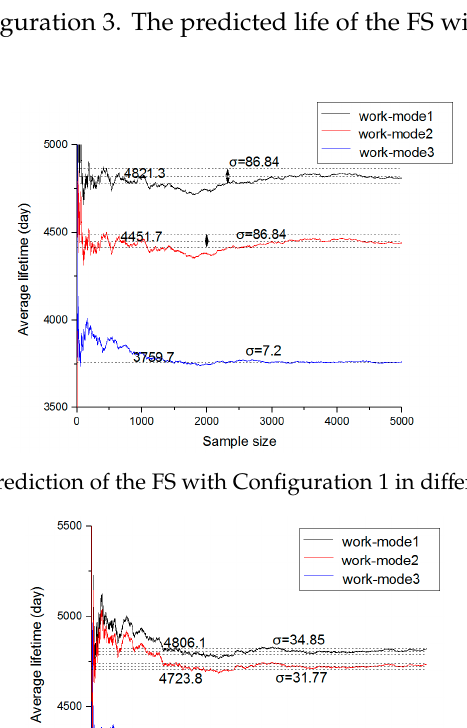
Figure 24. Life prediction of the FS with Configuration 1 in different work modes.